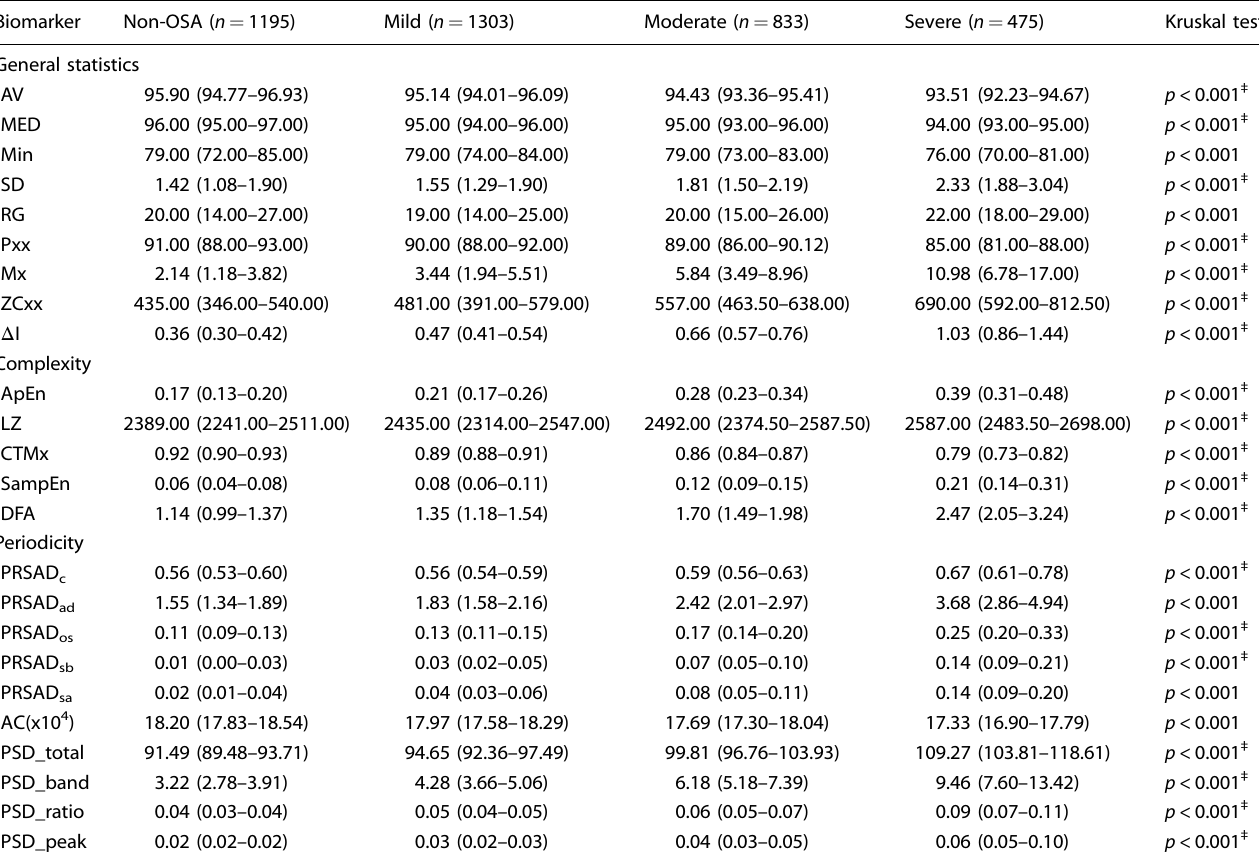
Table 1. Summary statistics (median and interquartiles Q1 – Q3) for the General statistics, Complexity and Periodicity OBMs evaluated on the SHHS1 database.